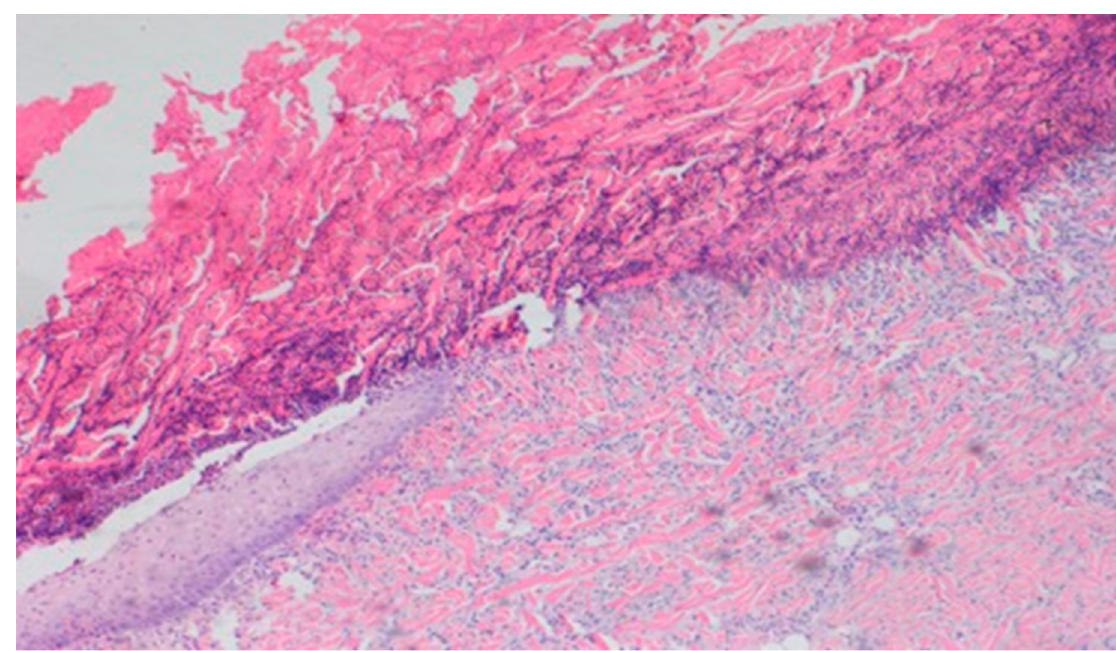
Figure 15. Granulocytic inflammatory infiltration, medium density. No epidermization, with slight necrosis (40×, H-E) in the wound treated with the ointment with 1% propolis and 1% nanosilver, on day 10.